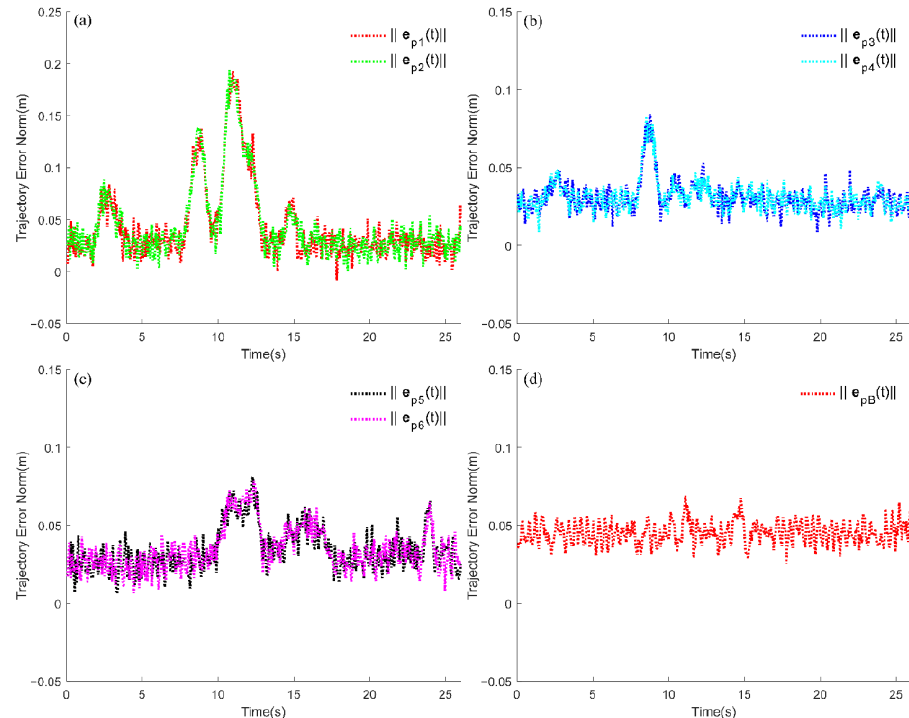
Figure 15. Trajectory error norm of tracked robots through short step. Subfigure ( a ) indicates the error norms of the front flipper. Subfigure ( b ) indicates the error norms of the middle flipper. Subfigure ( c ) indicates the error norms of the rear flipper. Subfigure ( d ) indicates the error norm of the center of mass.